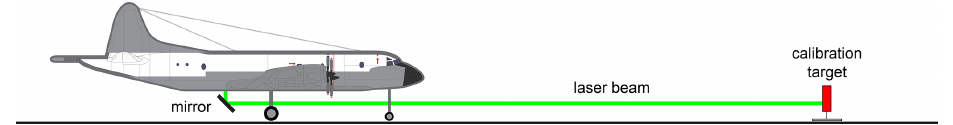
Figure B1. Range bias determination (a.k.a. ground test) using a calibration target with a known distance. The range to the calibration target is measured with an electronic distance meter (a.k.a. “total station”) with an accuracy of a few millimeters.